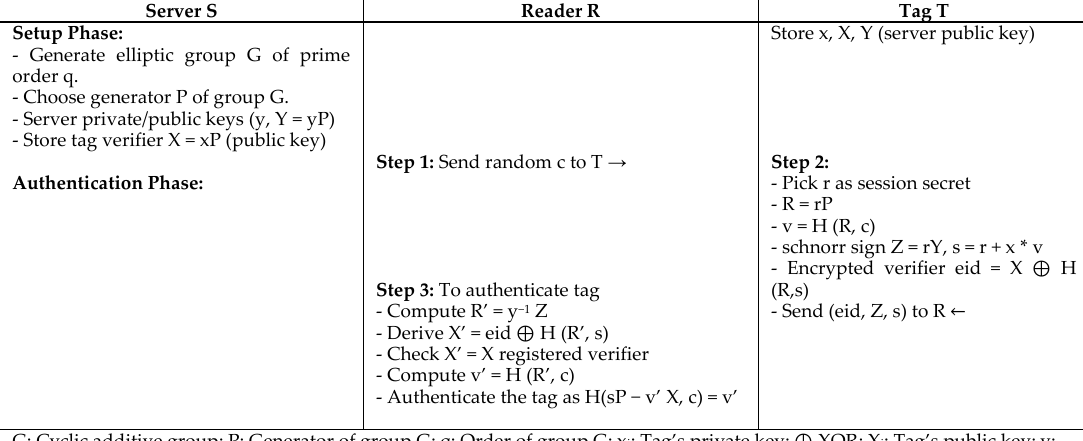
Figure 4. Elliptic Curve Cryptography-Based Untraceable Authentication Protocol (ECU) by Ryu.